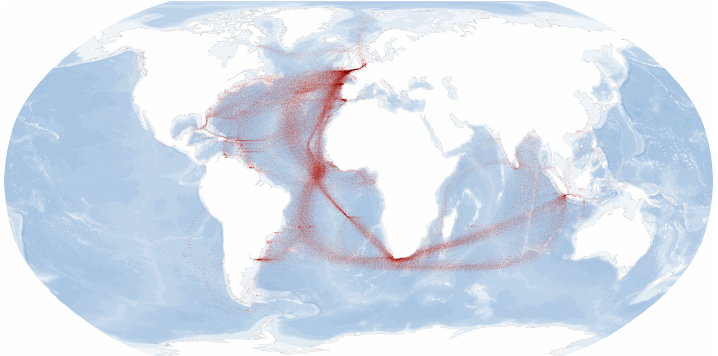
Figure 10. Plot of the position of all ships’ logbook entries in the CLIWOC database (Degroot and Ottens, 2021). The map is derived from the open-source variant of the CLIWOC database (García-Herrera et al., 2005b) held at https://www.historicalclimatology.com (last access: 3 June 2021). Table 1. Criteria used in the generation of seven-point temperature indices for “warm” ( + 2/ + 3) or “cold” ( − 2/ − 3) months in Switzerland (after Pfister, 1992, and Pfister et al., 2018). Bold text indicates criteria grounded in statistical analyses. Month “Cold” “Warm” (index values of − 2/ − 3) (index values of + 2/ + 3) Dec, Jan, Feb Uninterrupted snow cover Scarce snow cover Freezing of lakes Early vegetation activity Mar Long duration of snow cover Early sweet cherry flowering Frequent snowfalls No snowfall Apr Several days of snow cover Frequent